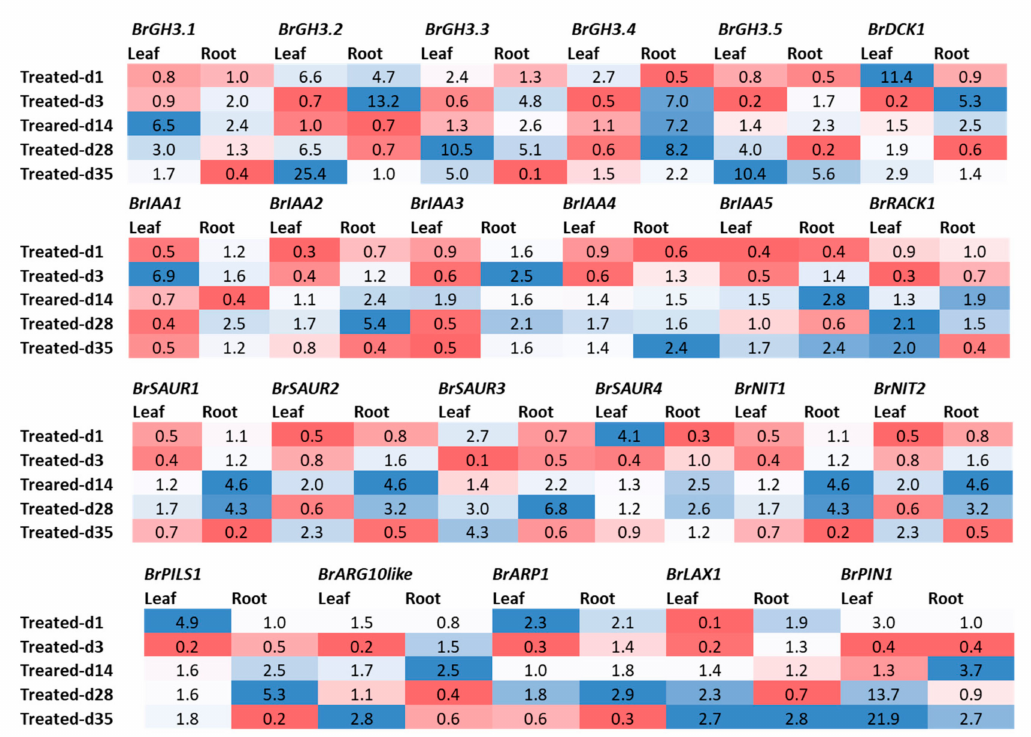
Figure 4. Fold changes in relative expression levels of auxin-related genes in Seosan-inoculated plants compared to mock-treated leaf and root samples at the same time point: Blue and red colors represent upregulation and downregulation of genes,